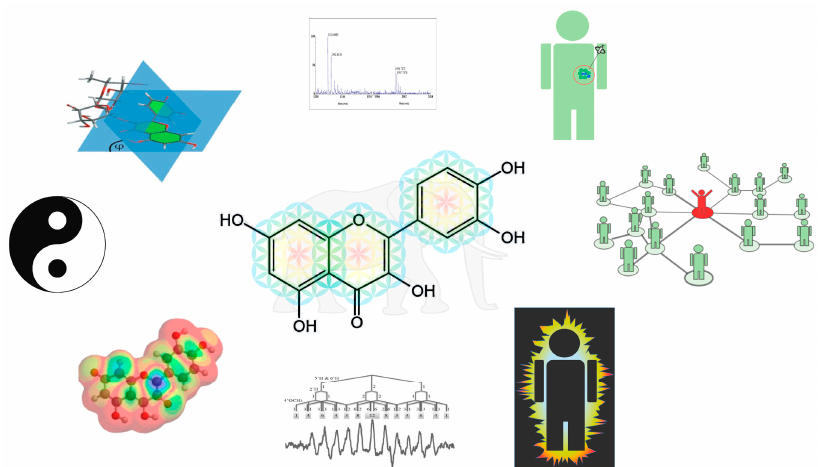
Figure 2. By combining the results obtained with different techniques and from different perspectives, a more complete picture on the effect of compounds can be obtained. Like in the metaphor, you than see that it is not a tree, a wall, a snake, or a rope; it is an elephant. And when you look even closer you might see how the compound is connected to life. Figure adapted from [4].